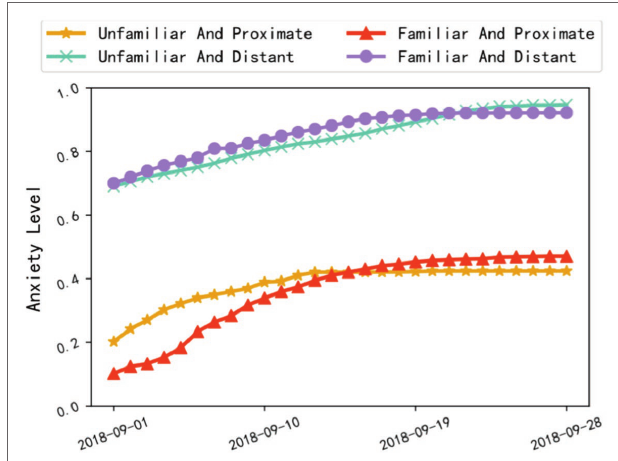
FIGURE 2 | Correlation between topic (familiar/unfamiliar and proximate/ distant) and collective anxiety